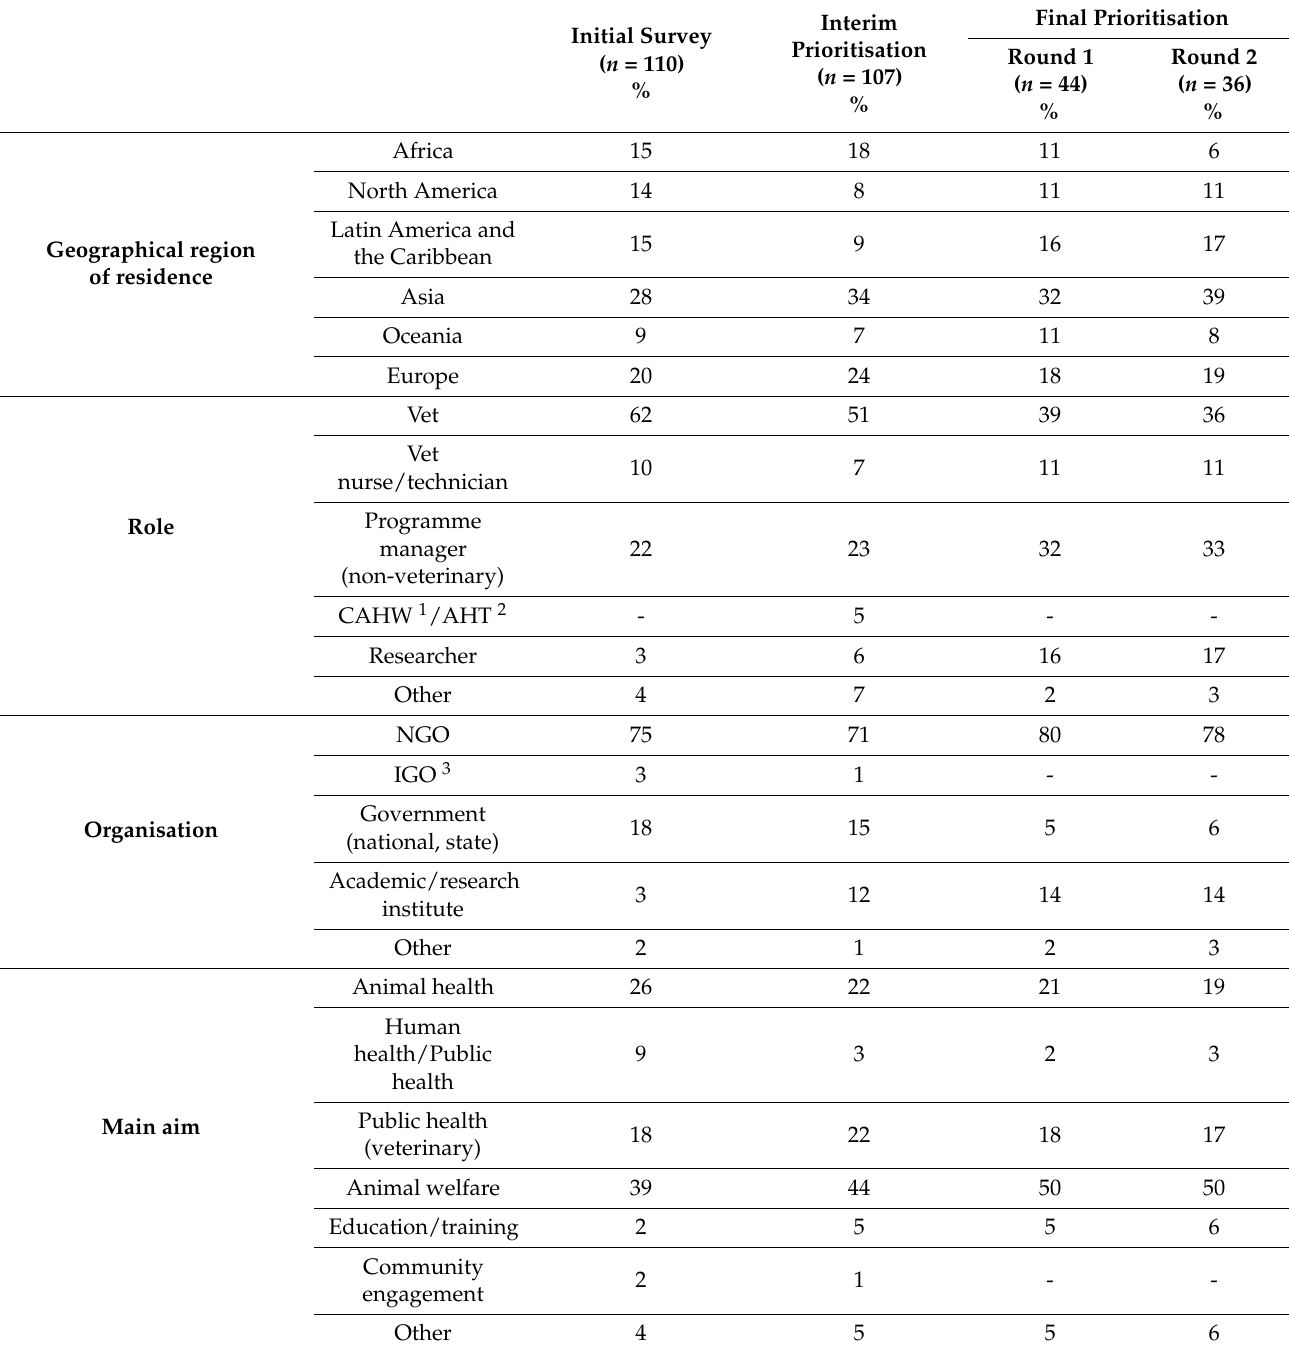
Table 1. Summary of participant